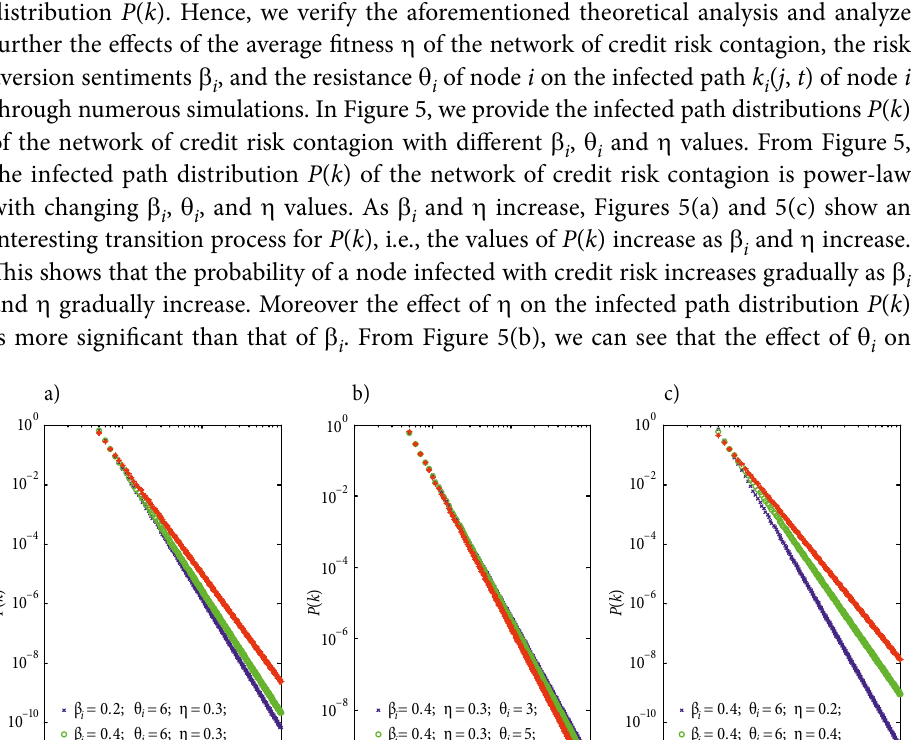
, q and h in logarithmic i i